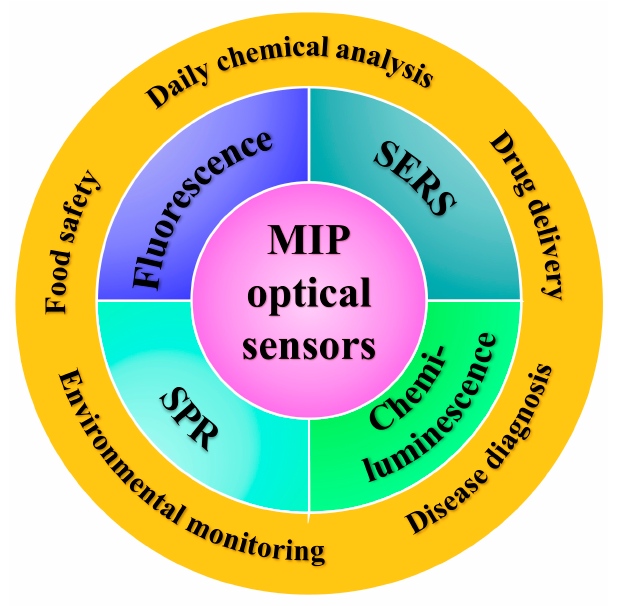
Figure 2. Schematic illustration of MIP optical sensors for application.